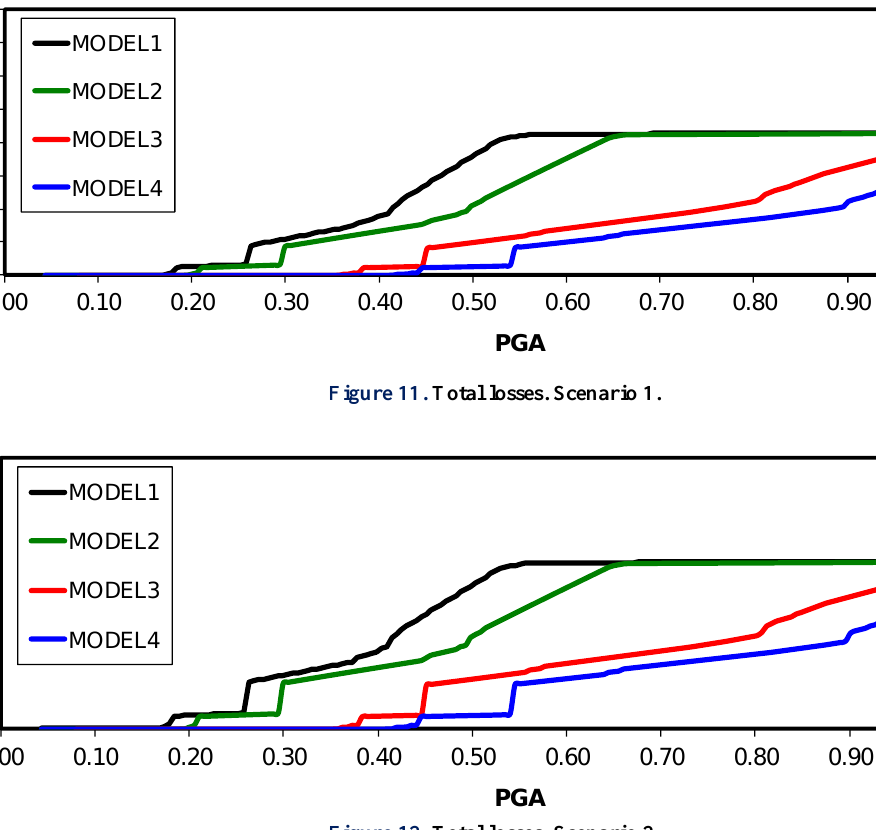
Figure 12. Total losses. Scenario 2.